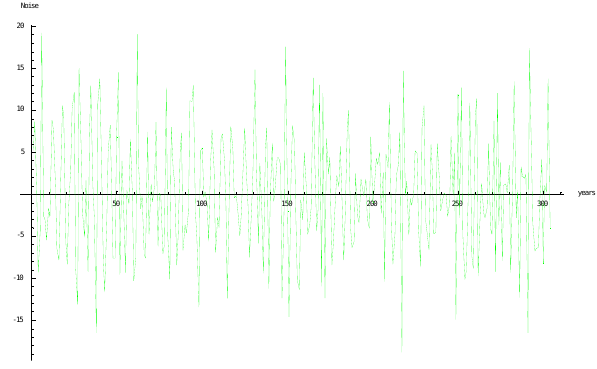
Fig. 3. Nonlinear function ψ for cycle 20.